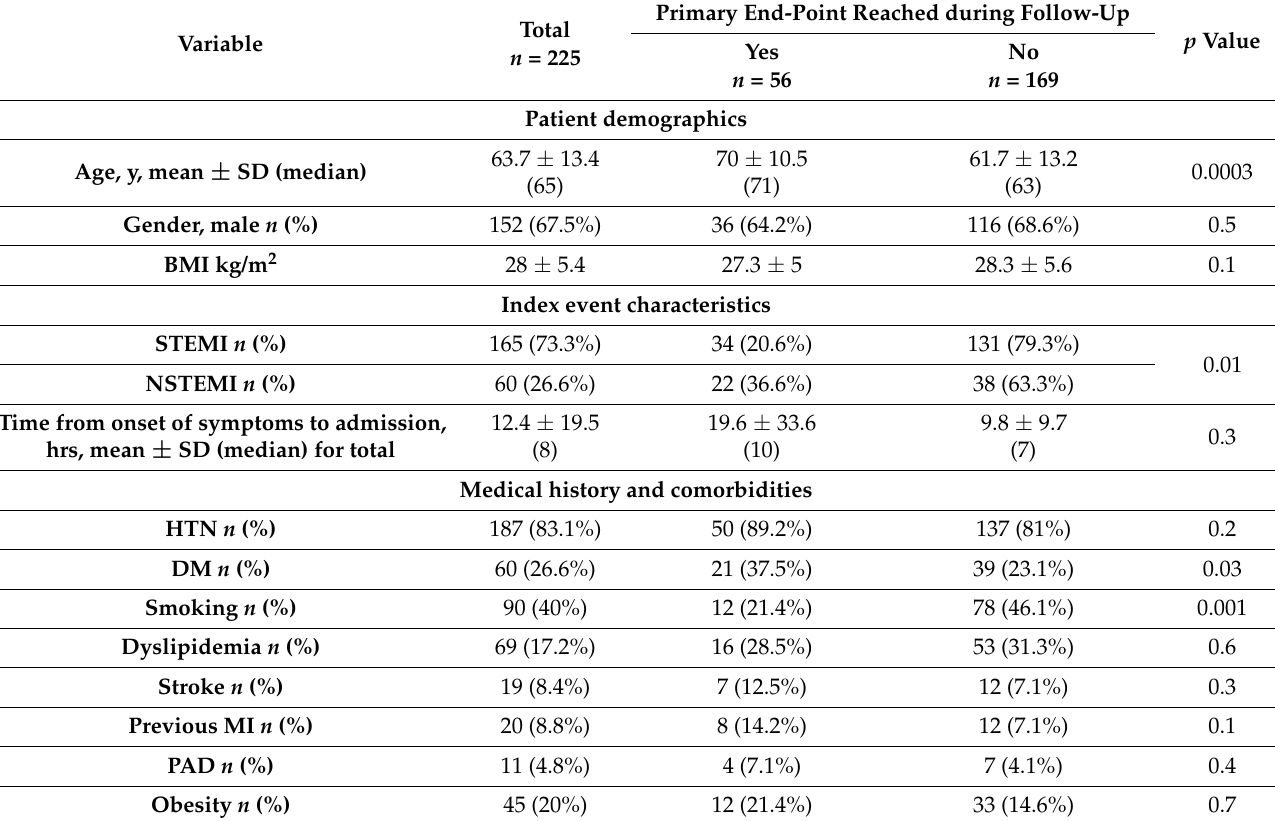
Figure 2. MACE rates in STEMI versus NSTEMI patients. The occurrence of 1 year MACE was significantly more frequent in patients with NSTEMI. Table 1. Clinical and biochemical characteristics of the study population and comparative analysis between the two study groups.